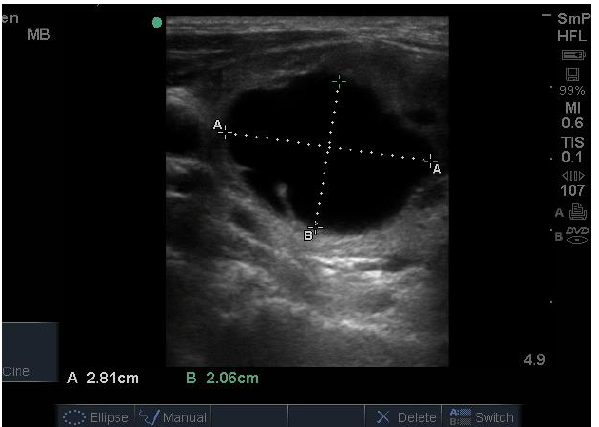
Figure 5. Thyroid nodule in a patient with hyperthyroidism shown, from technetium uptake and scan, to be “hot” or “toxic”.